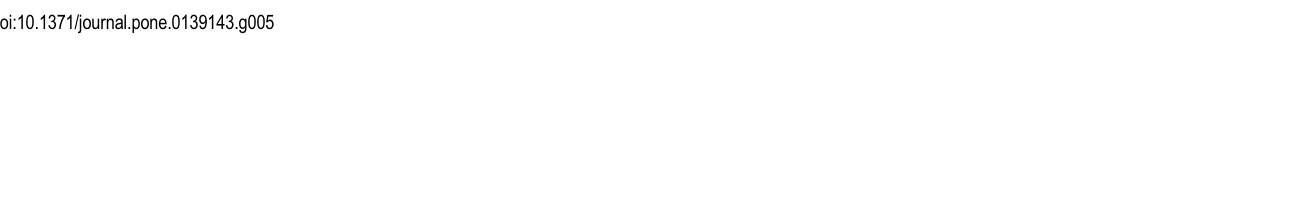
PLOS ONE | DOI:10.1371/journal.pone.0139143 September 24,